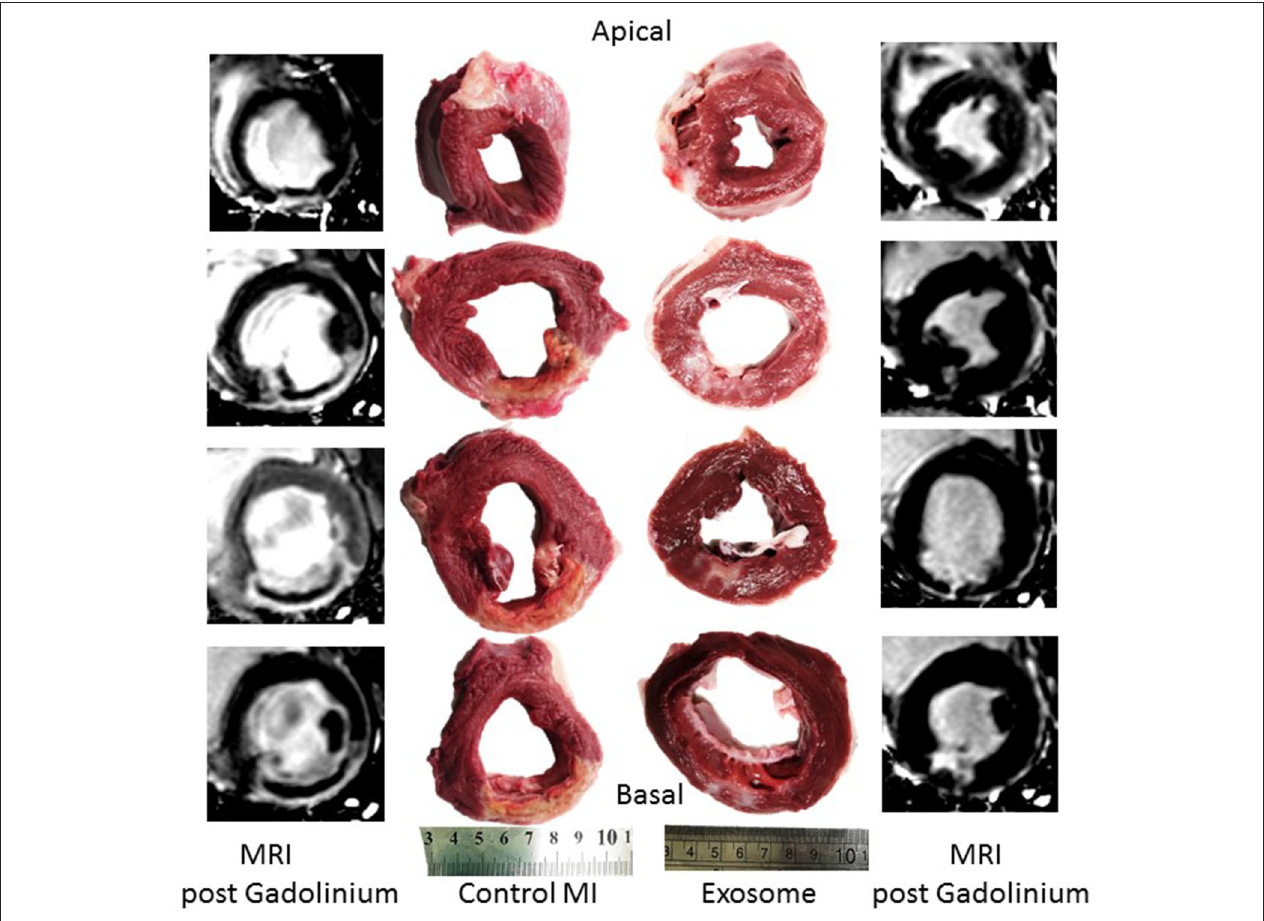
FIGURE 3 | Examples of MRI post-gadolinium short axis images of left ventricle 28 days post-MI and corresponding gross pathology from post mortem left ventricular rings showing infarct vs. normal myocardium from a representative exosomes treated and control treated MI